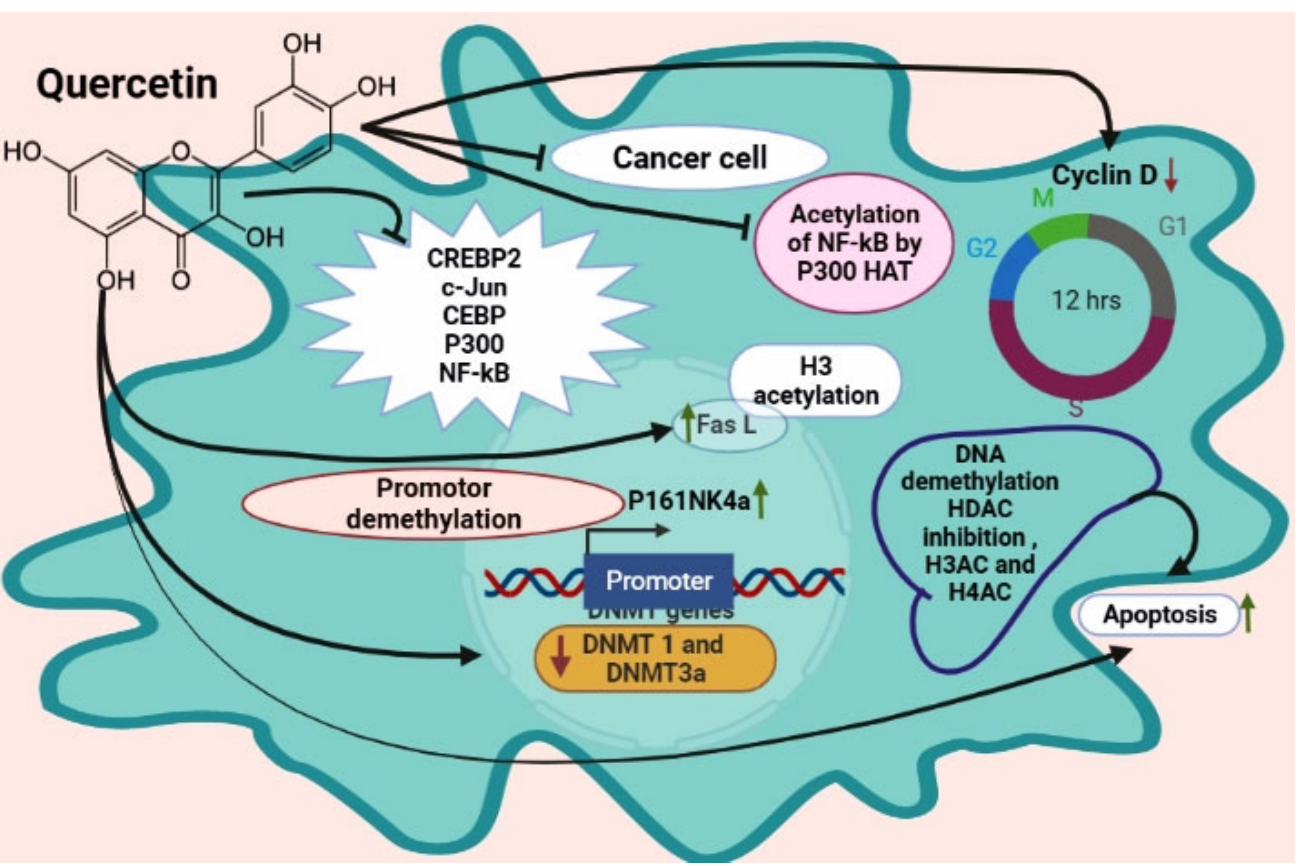
Figure 3. Quercetin protects from cancer via an epigenetic mechanism. Quercetin inhibits NF ‐ kB acetylation by p300 HAT; decreases cyclin D; increases Fas L via H3 acetylation; increases P161NK4a via promoter demethylation; decreases DNMT1 and DNMT3a; DNA methylation HDAC inhibition, H3AC, and H4AC, and increases apoptosis; inhibits the transcriptional CREBP2, c ‐ Jun, CEBP; P300 and NF ‐ kB.